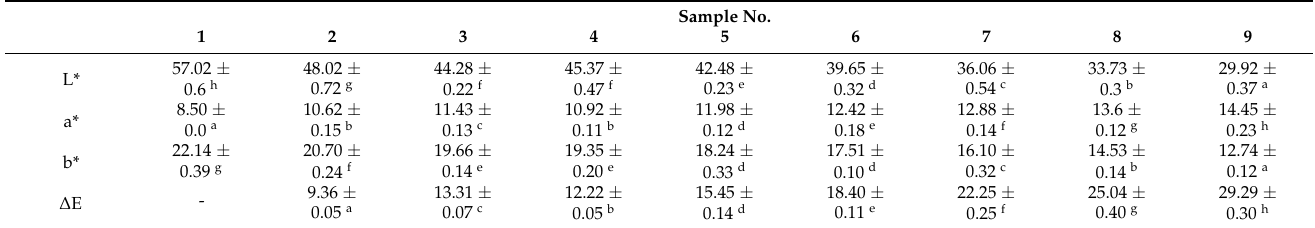
Table 6. Descriptive sensory analysis of cookies with and without the addition of L and OL peach.